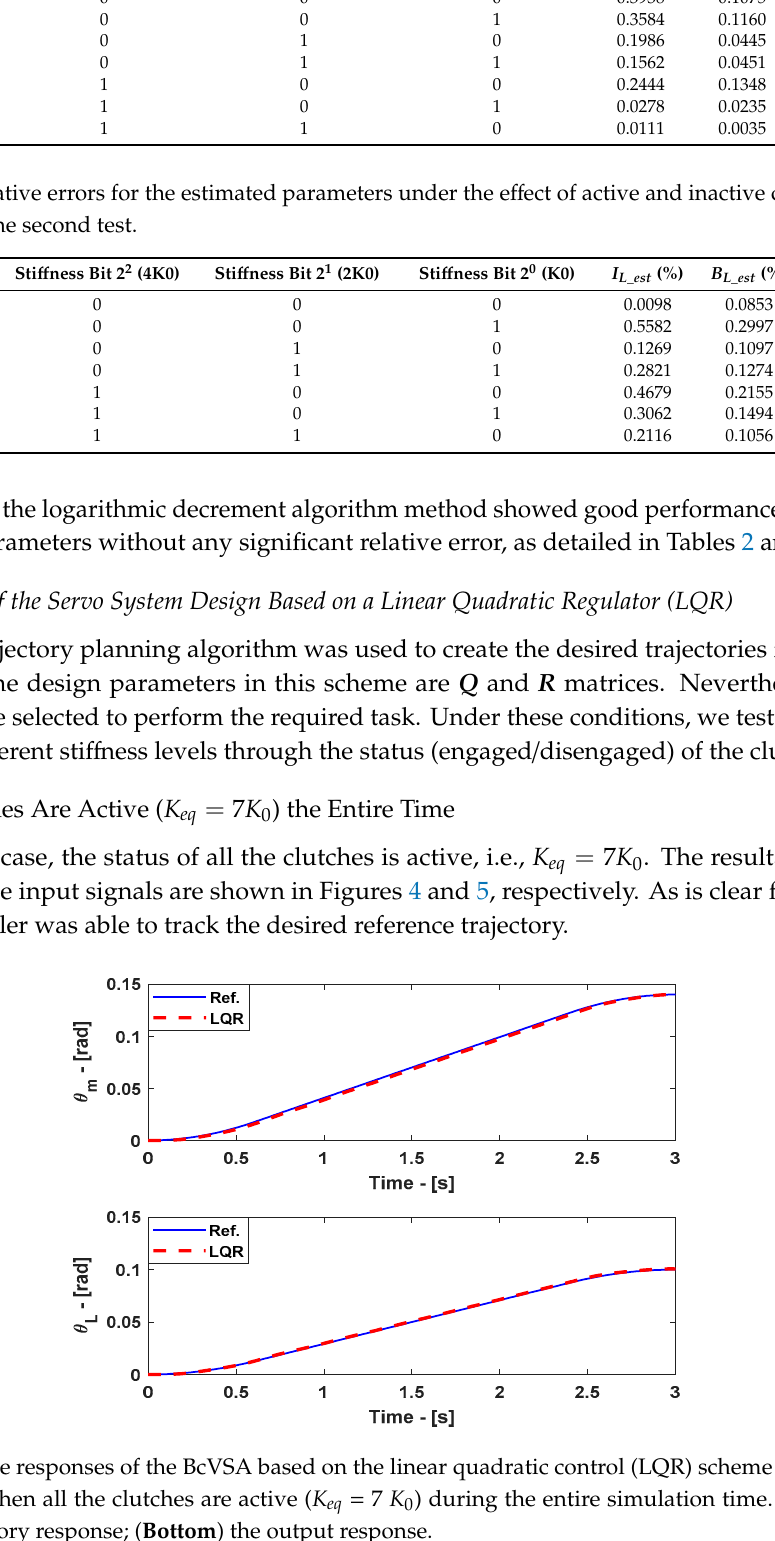
Figure 5. The input signals of BcVSA based on the LQR scheme under the condition when all the clutches are active ( 𝐾 (cid:3032)(cid:3044) = 7 𝐾 (cid:2868) ) during the entire simulation time. 5.2.2. Altering the Clutches’ Status While the System is Running at Different Time Intervals In this case, we used the same design parameters as chosen in the previous case, but this time we tested the controller ability to control the actuator by altering the stiffness level while the system